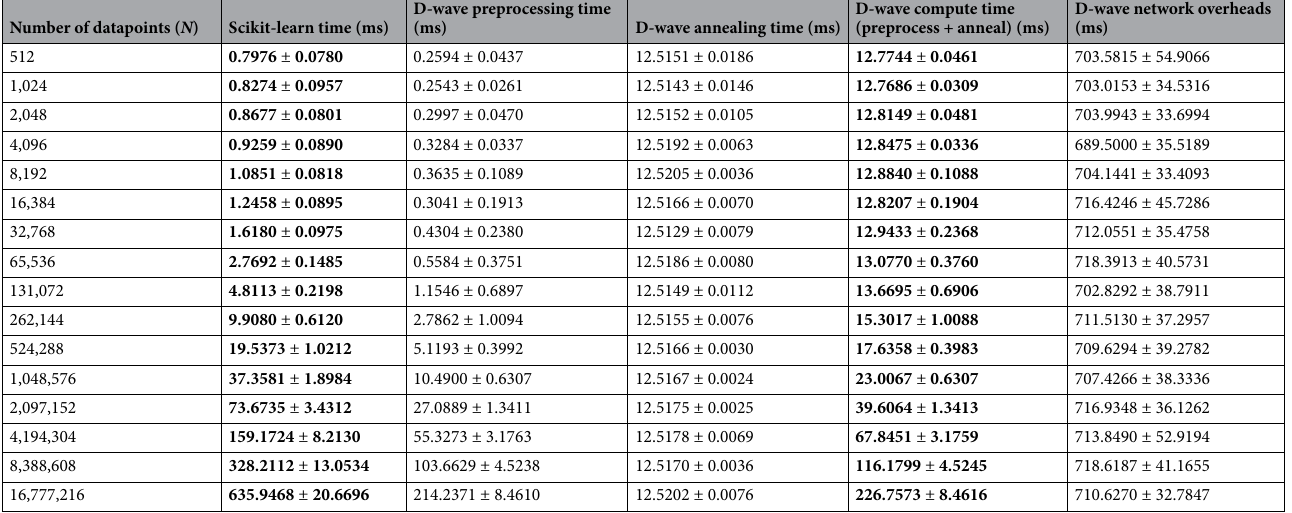
Table 2. Scalability with number of datapoints ( N ). Significant values are in bold.